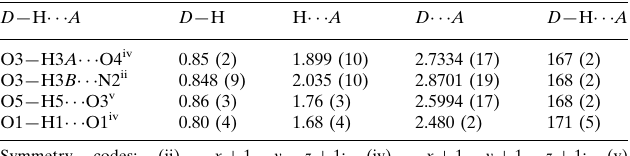
Hydrogen-bond geometry (A˚ , (cid:2)